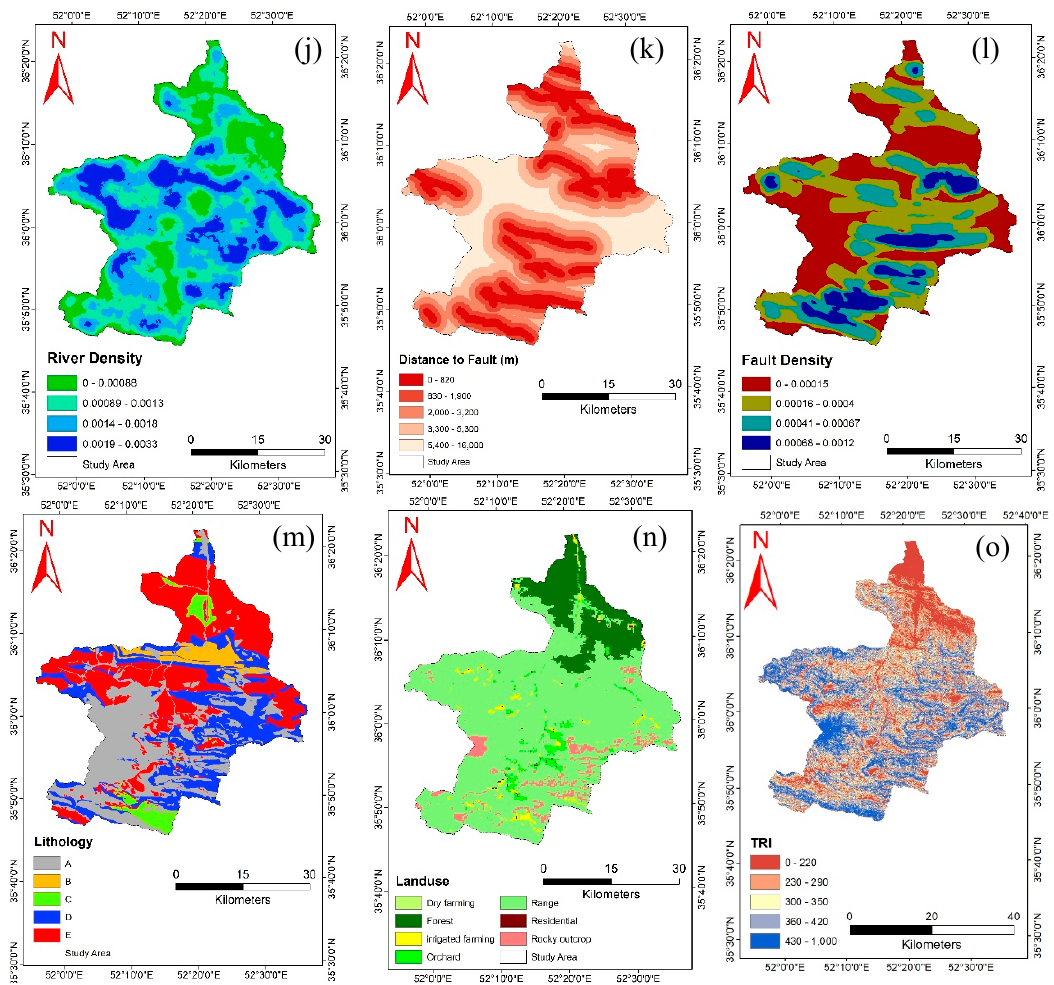
Figure 3. GCFs considered in this study: ( a ) slope angle, ( b ) slope aspect, ( c ) altitude, ( d ) plan curvature, ( e ) profile curvature, ( f ) slope length, ( g ) topographic wetness index, ( h ) stream power index, ( i ) distance from rivers, ( j ) river density, ( k ) distance from fault, ( l ) fault density, ( m ) lithology, ( n ) land use, and ( o ) terrain roughness index.